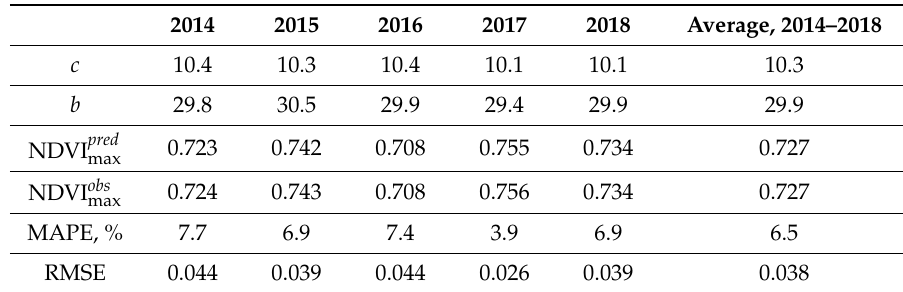
Table 4. Parameters of the NDVI approximation curves, the maximum NDVI values, and the model errors for the arable land in the Khabarovsk District in 2014–2018.